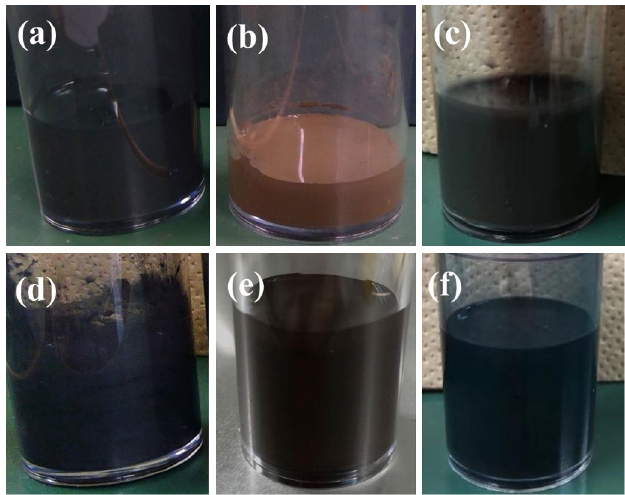
Figure 3. The appearance of 5 vol% ( a ) Mo, ( b ) Si, ( c ) MoB, ( d ) TiC, ( e ) Mo-Si, ( f ) Mo-Si-MoB-TiC slurries.